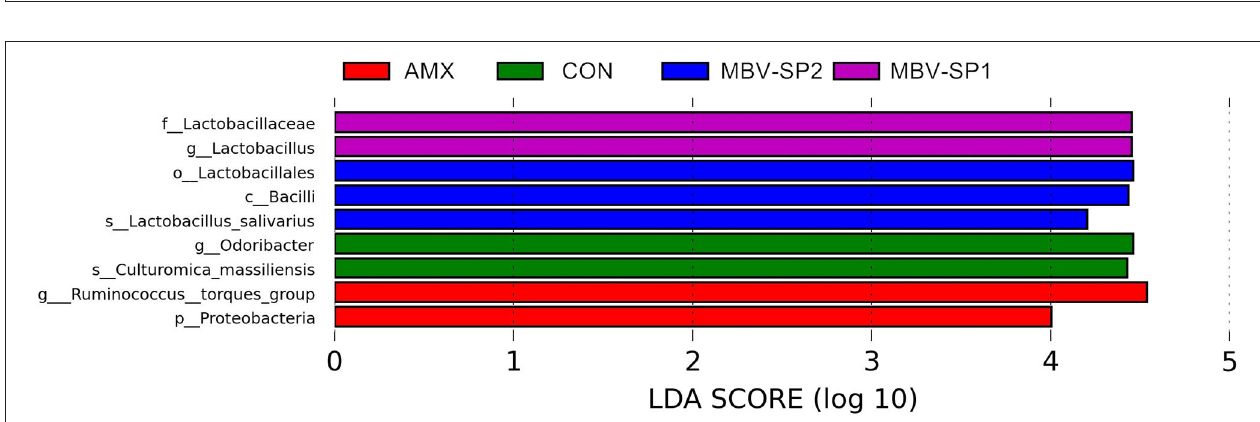
FIGURE 3 | LEfSe analysis showing the most differentially abundant taxa between control and treatment groups. Only taxa with LDA > 4 are shown. The letter in front of the strains indicates the taxon level; p, phylum; c, class; o, order; f, family; g, genus; s, species ( n = 5/each group). of intestinal structure and immune-modulating function